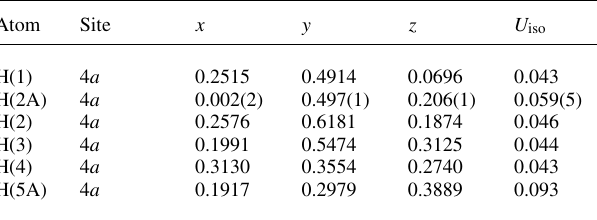
Table 2. Atomic coordinates and displacement parameters (in Å 2 ) .